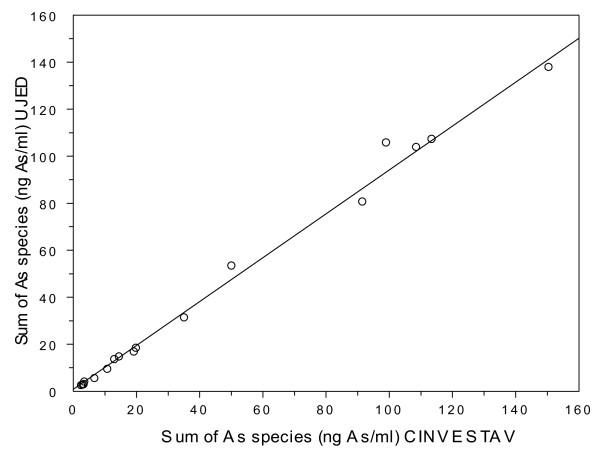
Correlation between sums of As species in urines of eighteen Zimapán residents analyzed in both Cinvestav-IPN and in Universidad Juárez del Estado de Durango (UJED): R = 0.997, p < 0.01).